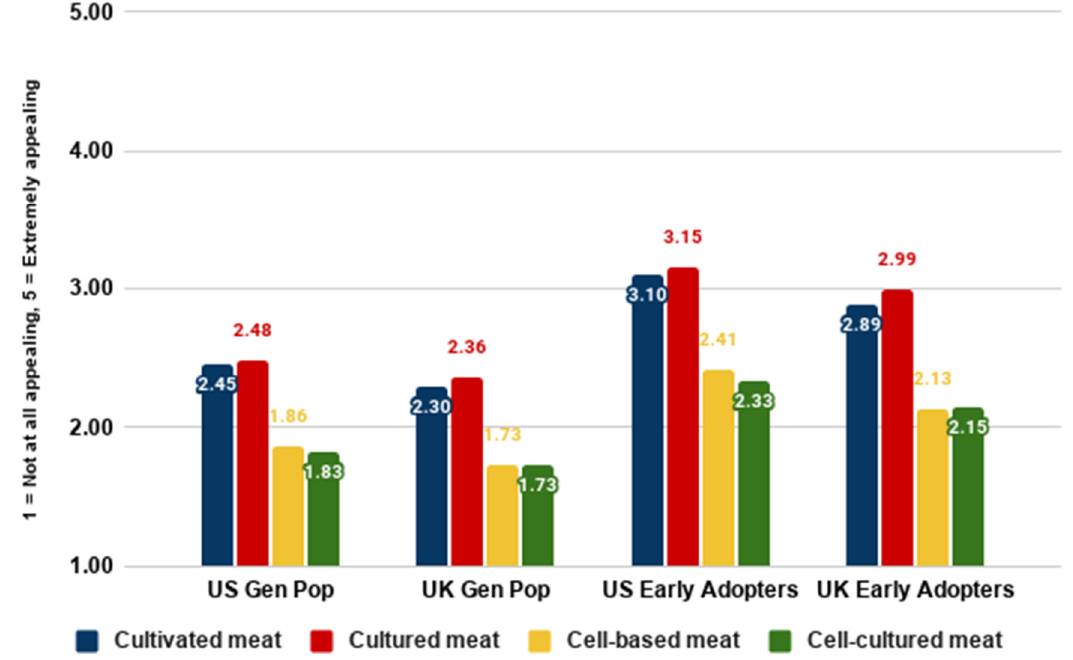
Figure 6. Appeal ratings for different names by country and segment.